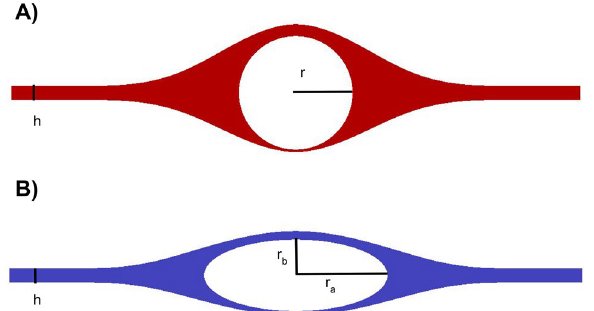
Figure 1. Computational domains for the idealized pial perivascular spaces surrounding an artery ( A ) and a vein ( B ) and simulating Stokes flow. In the baseline models, r = 20 µ m , r a = 32 µ m , r b = 12.5 µ m and h = 5 µ m .